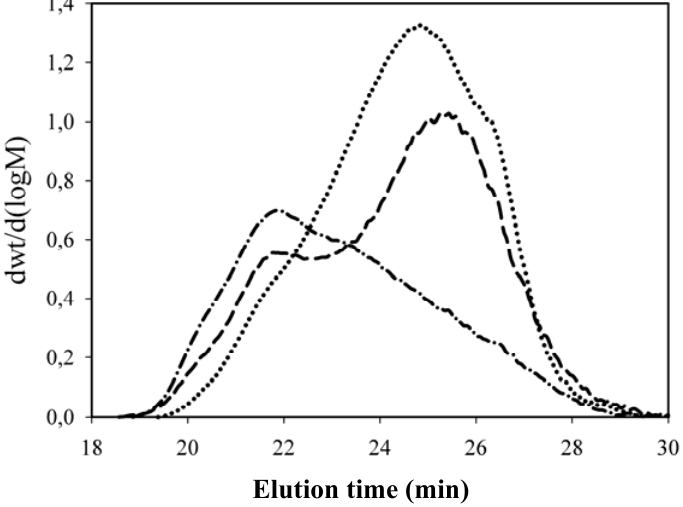
Figure 8. SEC chromatograms obtained for EVOH- g -PCL synthesis in mini twin-screw extruder at different temperatures: 176 °C (dotted), 186 °C (medium dash) and 200 °C (dash dot) (30 min